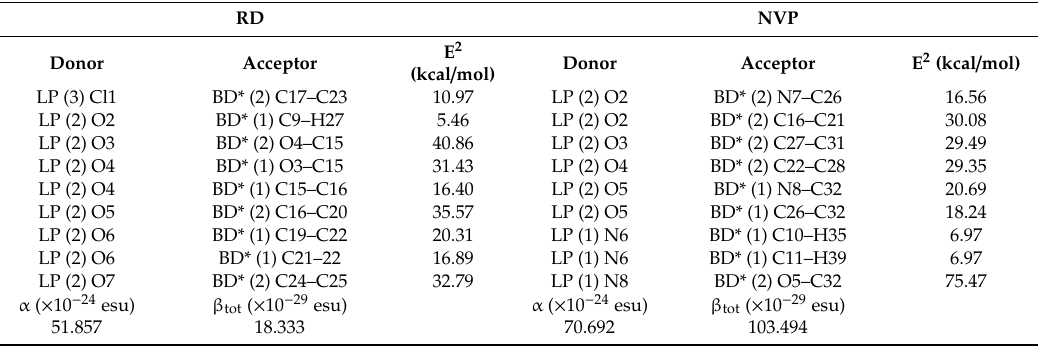
Table 2. The second-order perturbation energies E 2 (kcal / mol) corresponding to the important charge transfer interaction (donor → acceptor) within the inhibitors and their NLO properties at SMD / B3LYP / 6-311G(d,p) level of